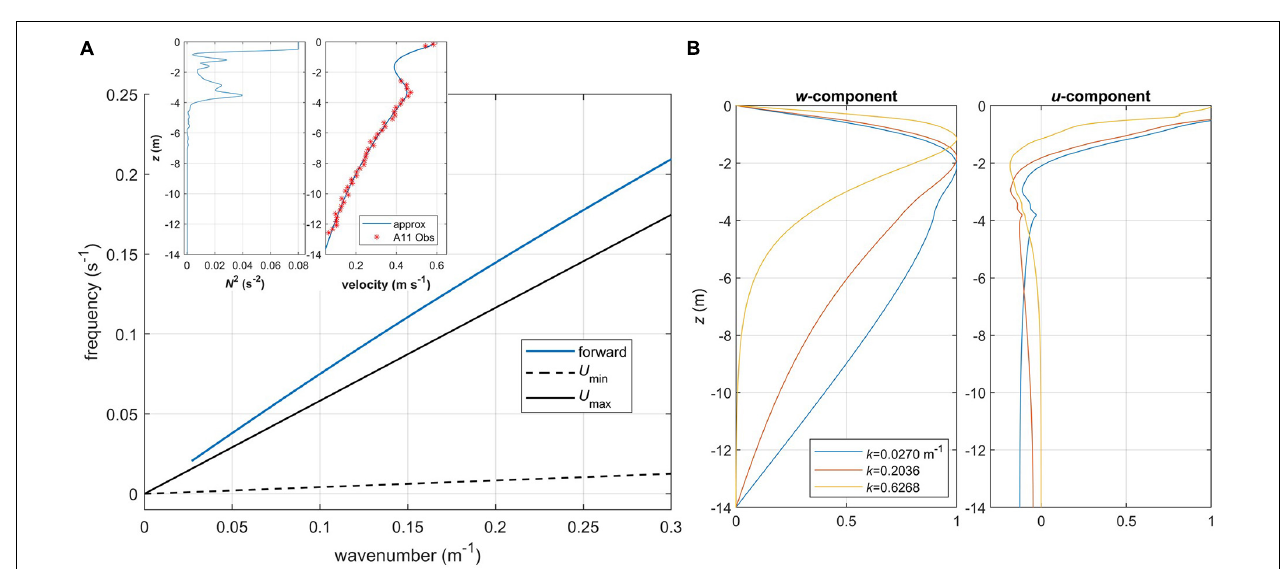
FIGURE 12 | Internal wave properties, case 2: (A) dispersion diagram for the first mode. Inset shows profiles of buoyancy frequency squared (left) and mean velocity (right) specified in the wave Equation A7; (B) vertical profiles of vertical and horizontal velocity components normalized by their maximum values for various wavenumbers k , backward propagating mode.